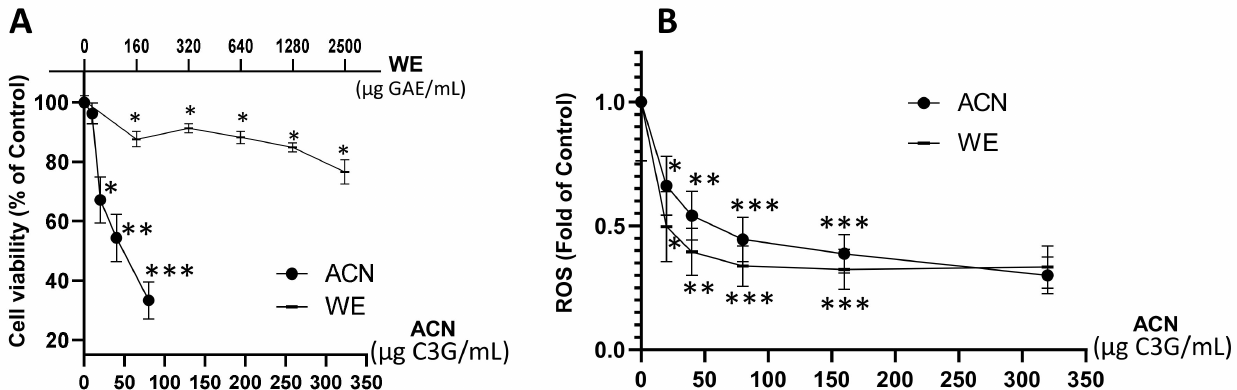
Figure 1. DSC extract enriched in ACN reduced 4T1 BC cell viability and ROS production. 4T1 cell viability ( A ). Cells were treated with ACN (10–80 µ g C3G/mL) or WE (160–2500 µ g GAE/mL, ~20–320 µ g C3G/mL) for 48 h. Cell viability was assessed using the in vitro toxicology resazurin based assay kit. ROS levels ( B ). Cells were treated with ACN or WE (20–320 µ g C3G/mL) for 48 h. Production of ROS was assessed with the Carboxy-H2DFFDA probe. RFU were normalized to cell density assessed using the Janus green reagent as detailed in the materials and methods section.